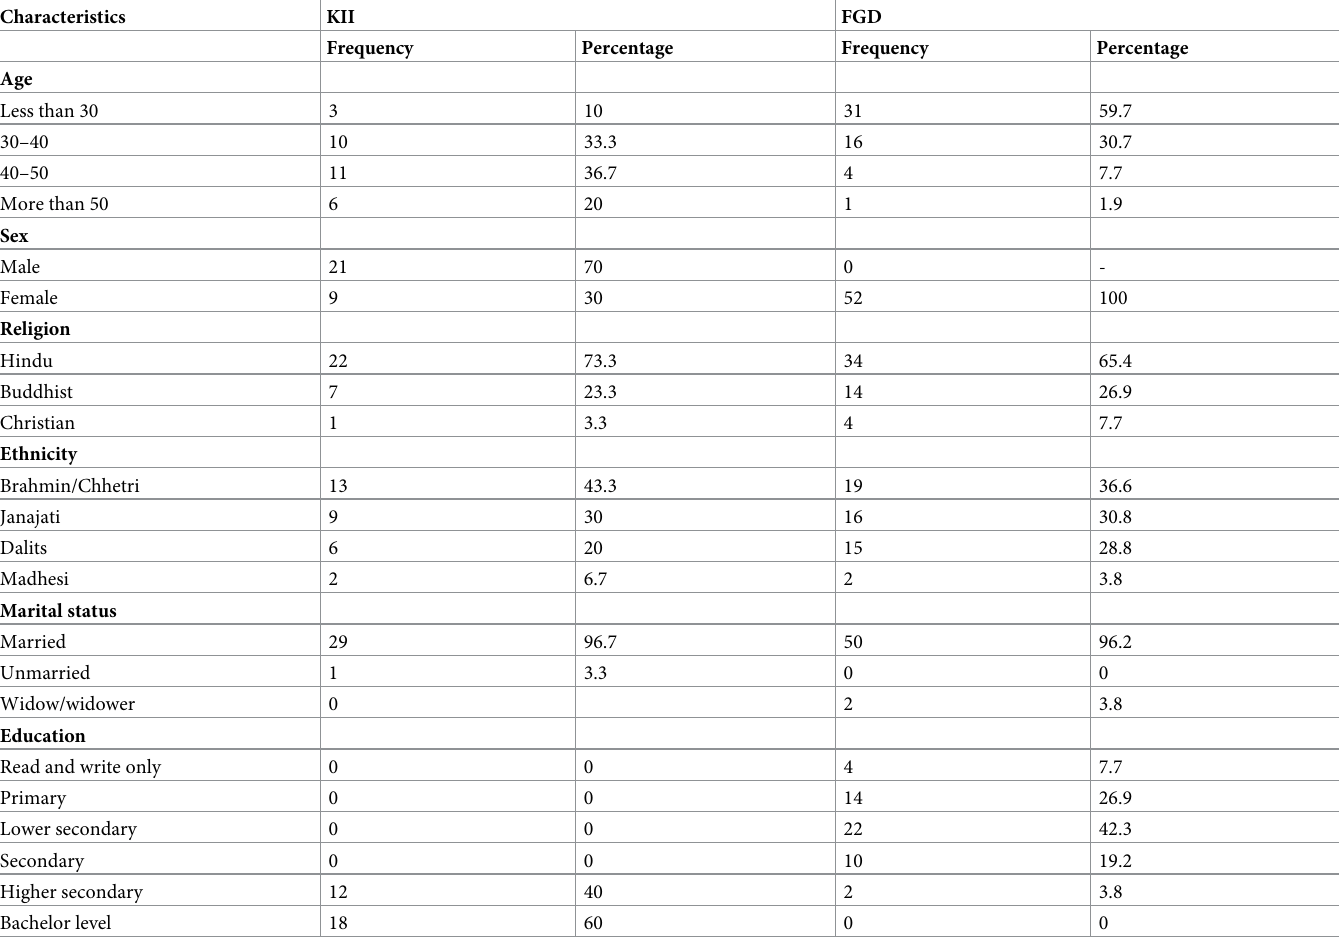
Table 3. The baseline characteristics of the participants.